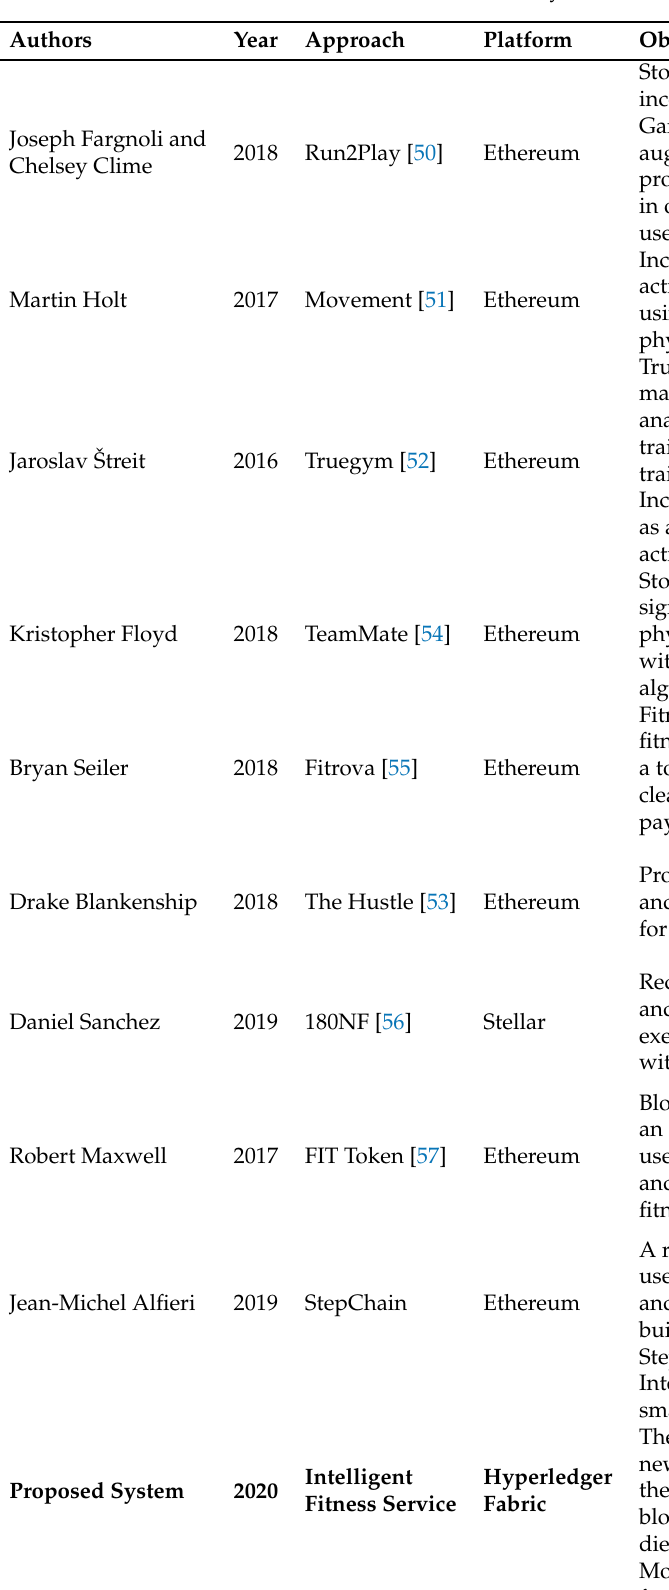
Table 3. Critical analysis of existing studies for fitness